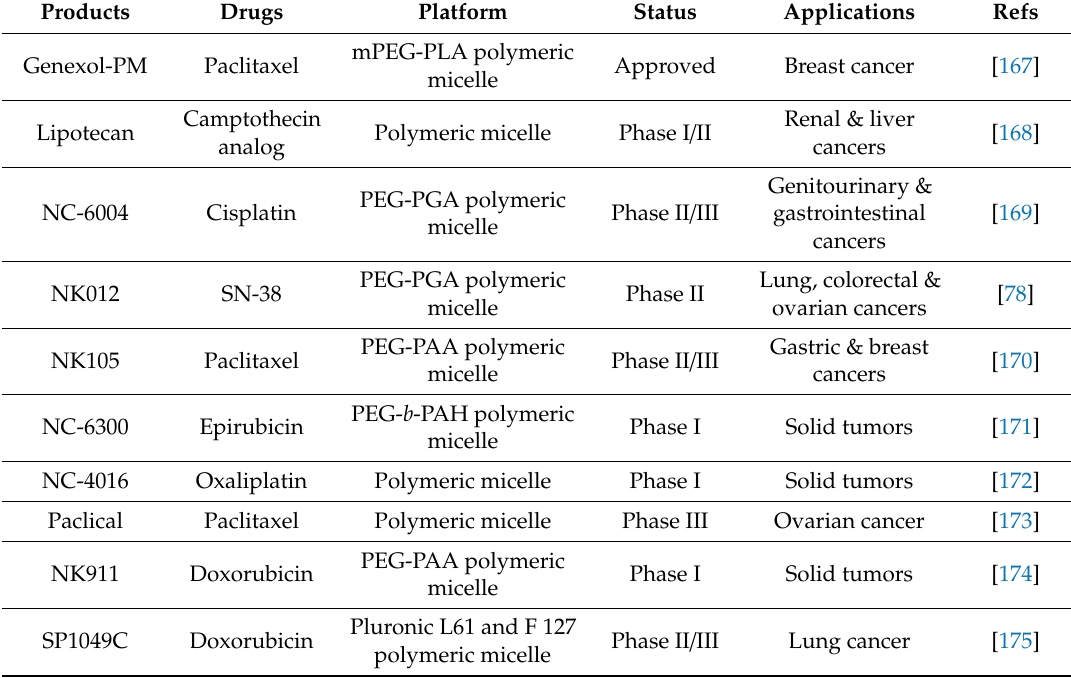
Table 4. The micellar NPs based drugs in clinical